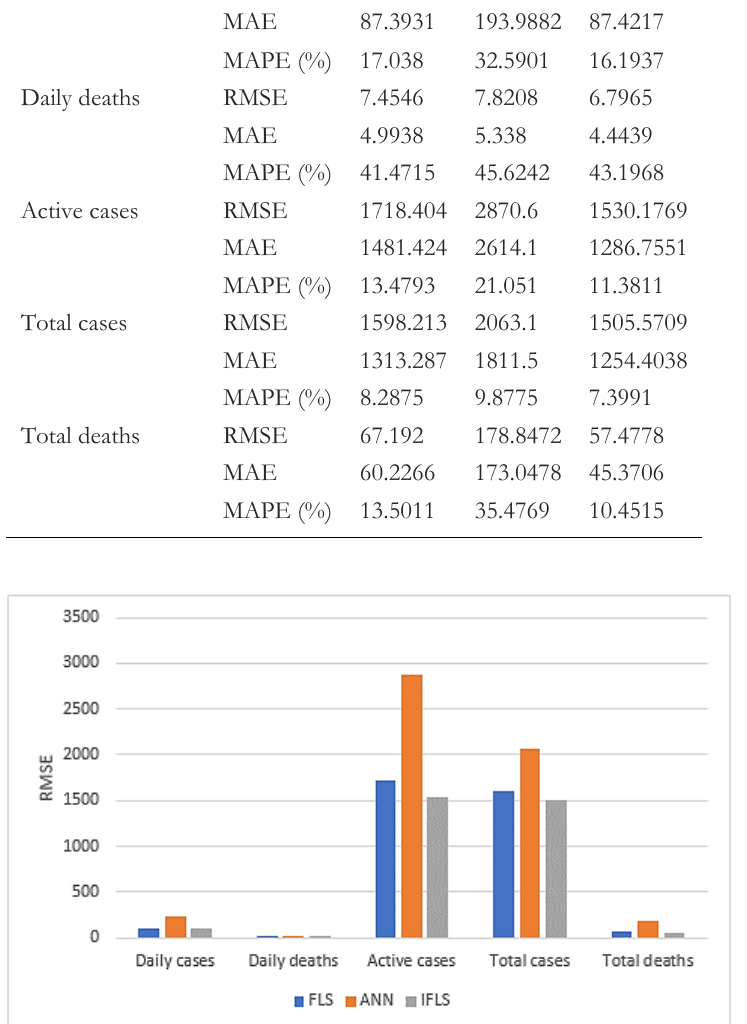
Fig. 11. RMSE for each model and COVID-19 case.